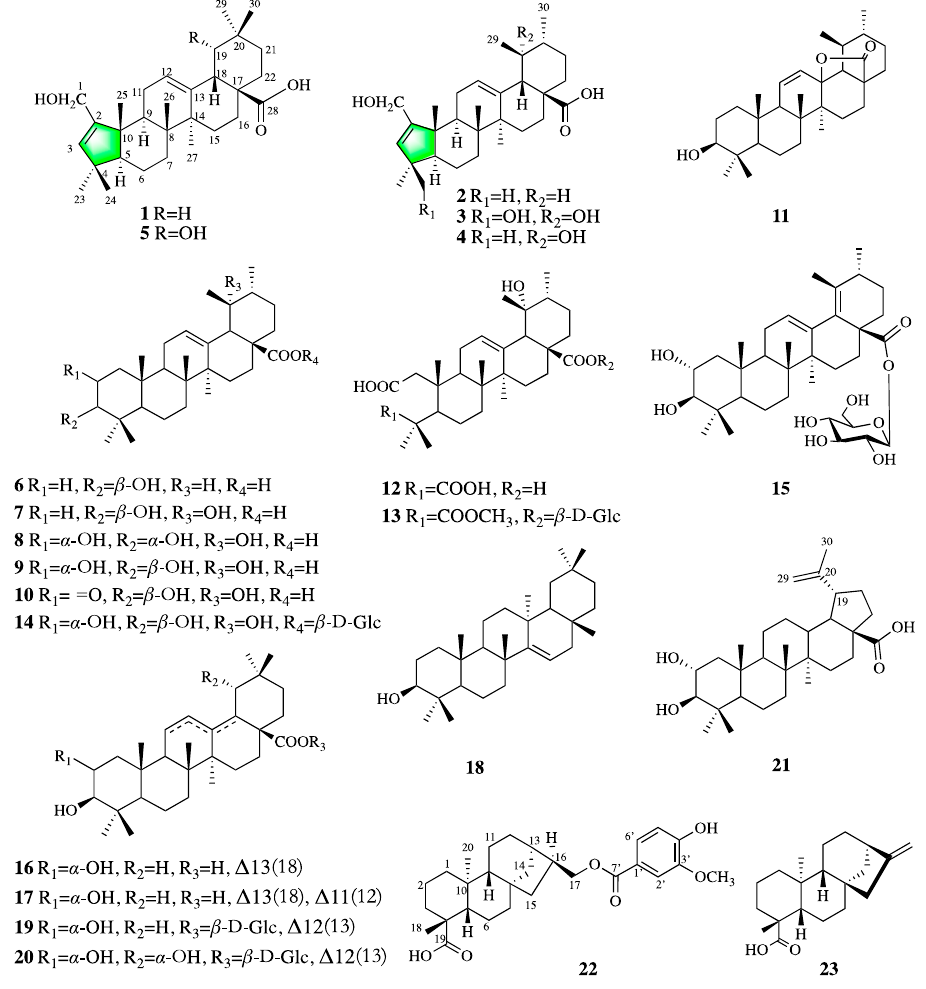
Figure 1. Chemical structures of compounds 1–23 .